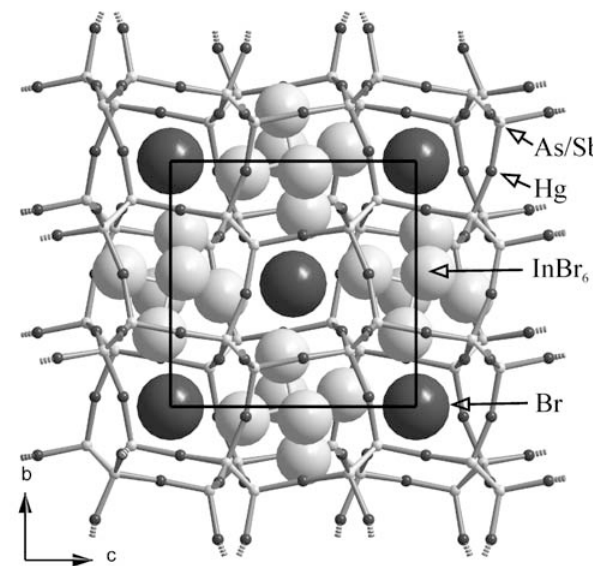
1. Tetraarsenidohexamercury hexabromoindate